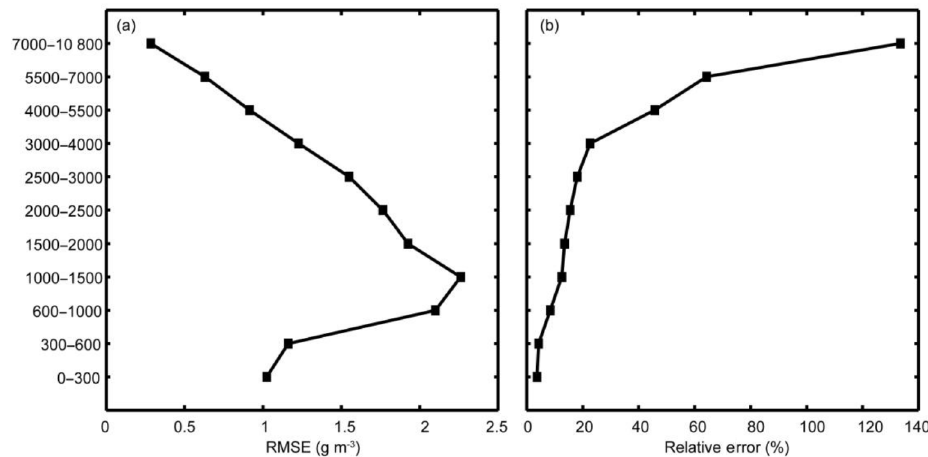
Figure 11. (a) Monthly RMSE of (absolute) tomographic errors and (b) mean of relative tomographic errors in different